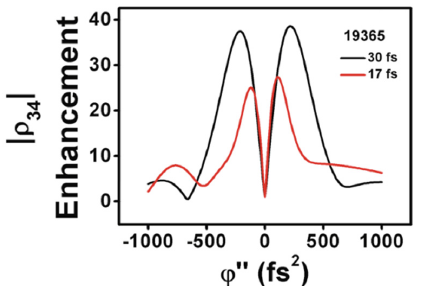
Figure 6. Enhancement of in | ρ 34 | with (cid:101) ν (cid:39) 19,365 cm − 1 and for pulse durations of 30 fs and 17 fs, as indicated.